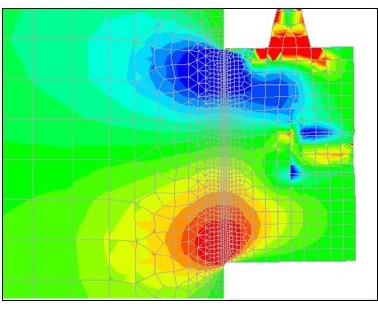
Fig. 13 Distribution of bending